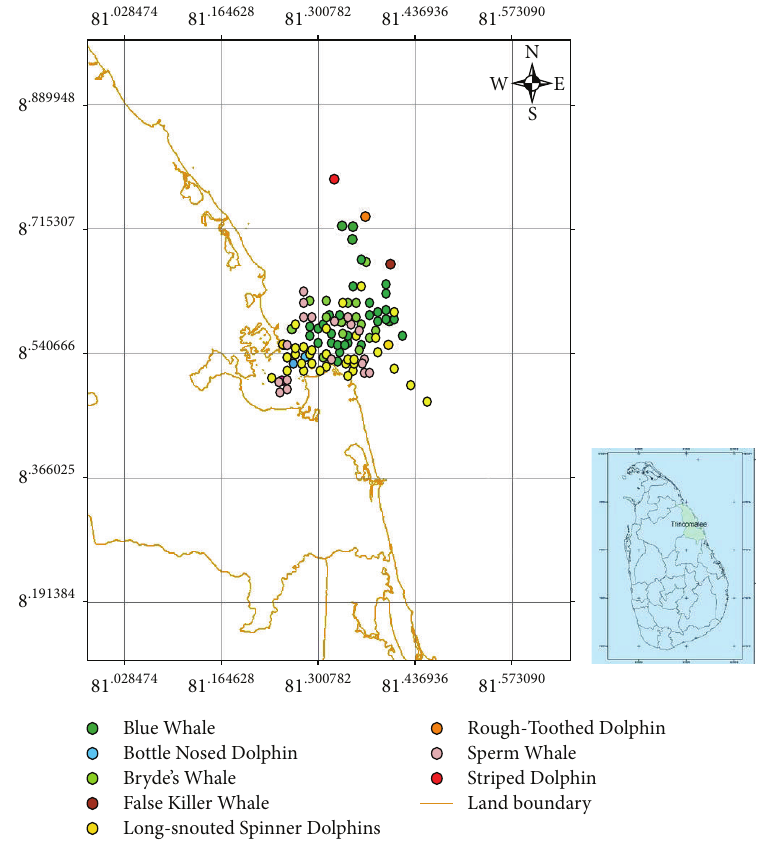
Figure 1: Locations of sightings of the cetacean species in Trincomalee bay and adjacent waters.